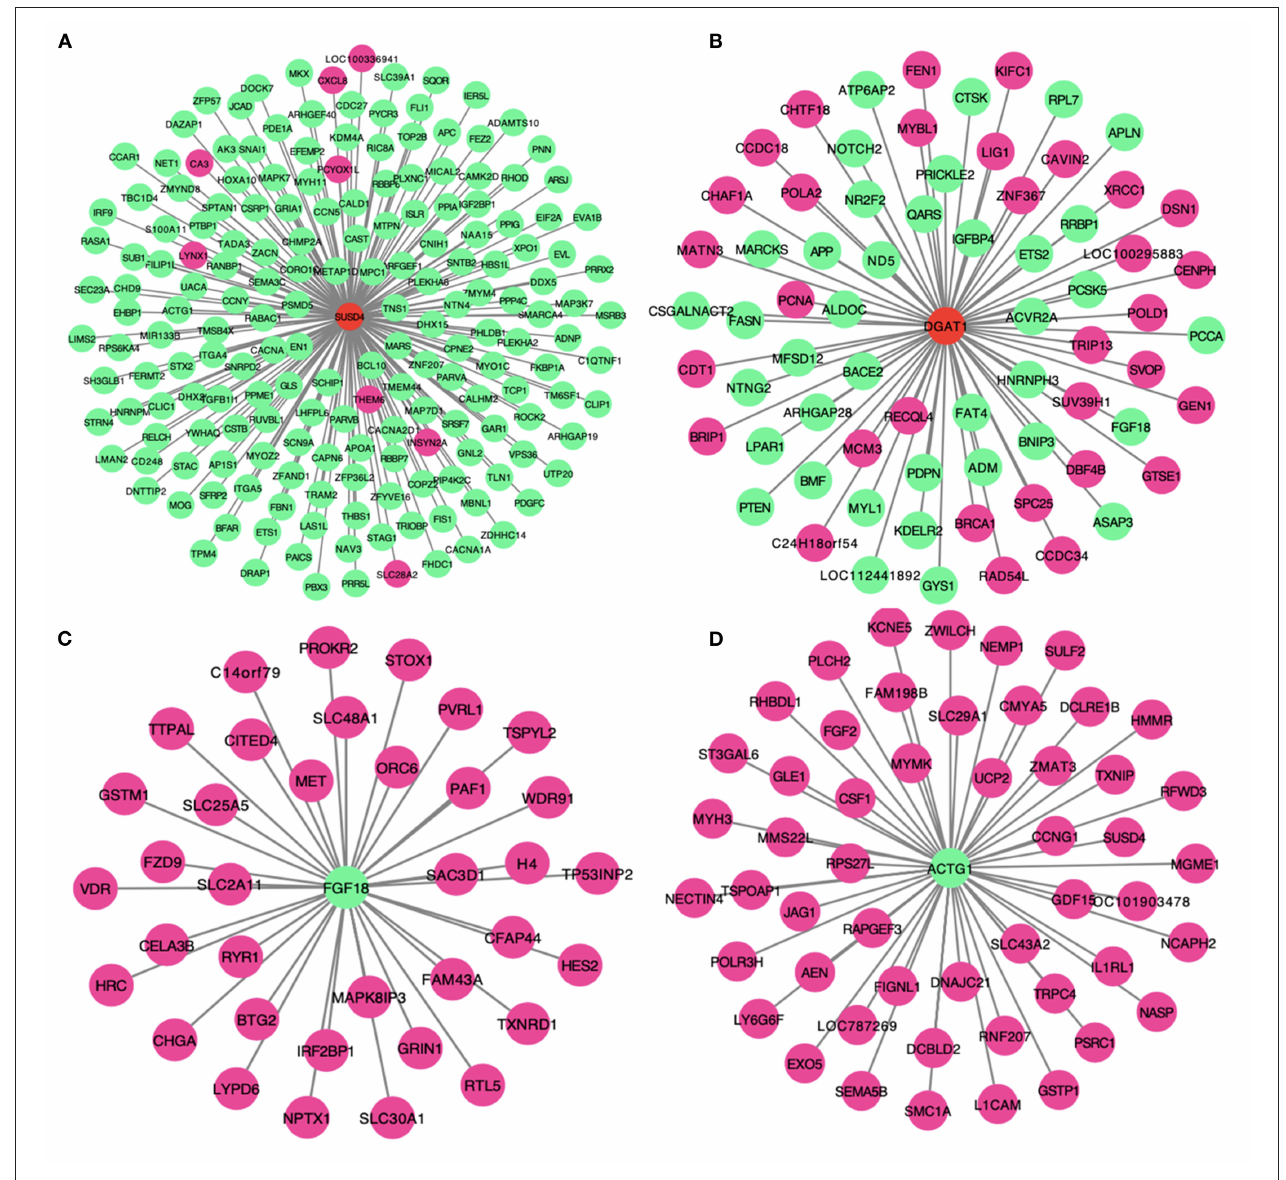
FIGURE 8 | The networks displaying the relationships of four key hub genes within co-expressed turquoise modules, i.e., (A) sushi domain containing 4 ( SUSD4 ) gene, (B) diacylglycerol O-acyltransferase 1 ( DGAT1 ) gene, (C) fibroblast growth factor 18 ( FGF18 ) gene, and (D) actin gamma 1 ( ACTG1 ) gene.